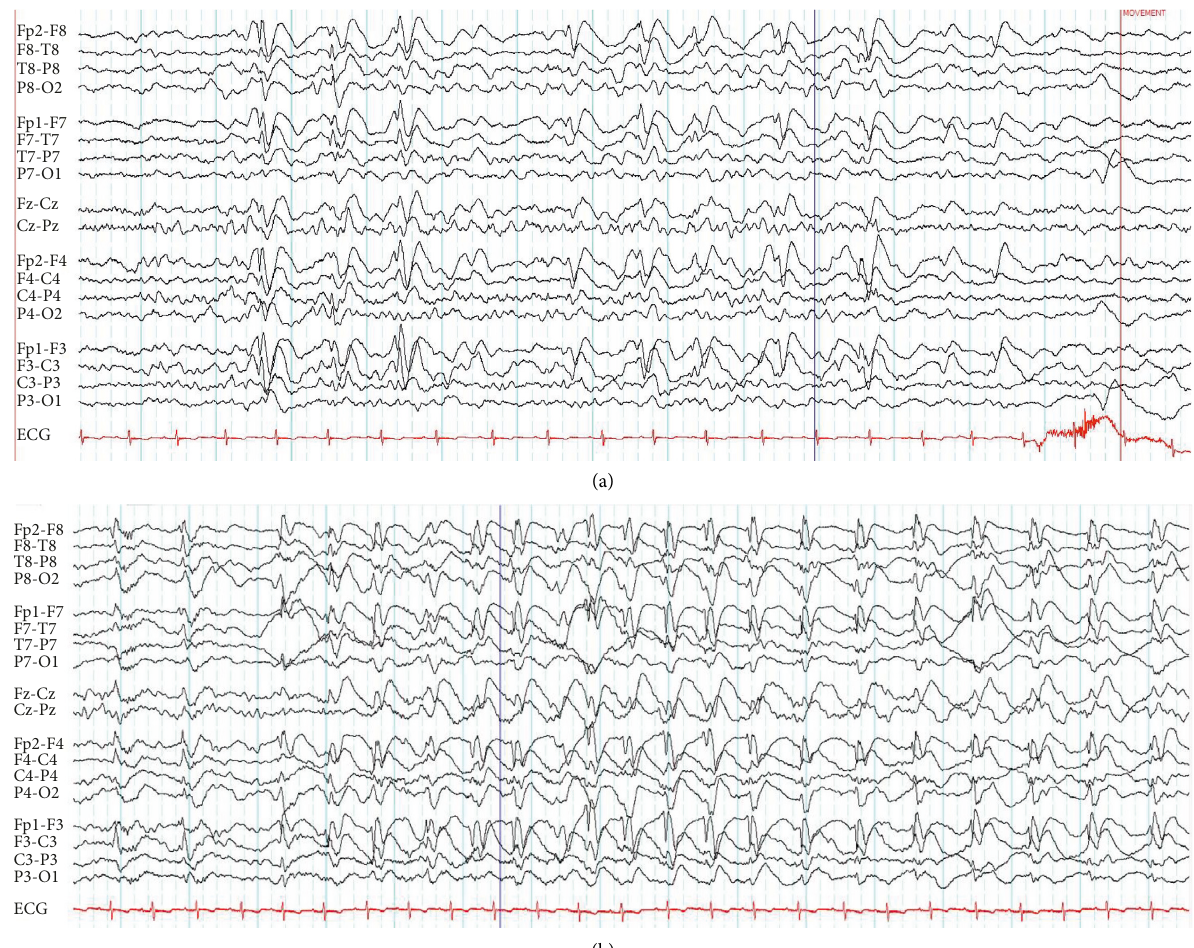
Figure 1: EEG during drowsy state with frequent intermittent high-voltage sharp and slow waves predominantly over bilateral frontopolar and frontotemporal regions (a) and EEG during sleep with long lasting and nearly continuous high-voltage sharp and slow waves over same regions (b). Sensitivity of bothEEG tracings is 15 u V/mm.